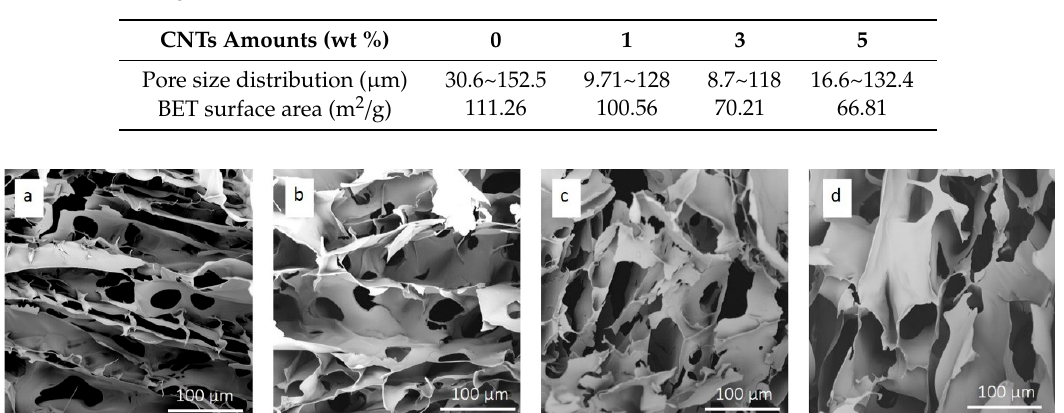
Table 2. The pore sizes distribution range and BET surface areas for different CNTs amounts of CMC (DS = 1.2) aerogels.